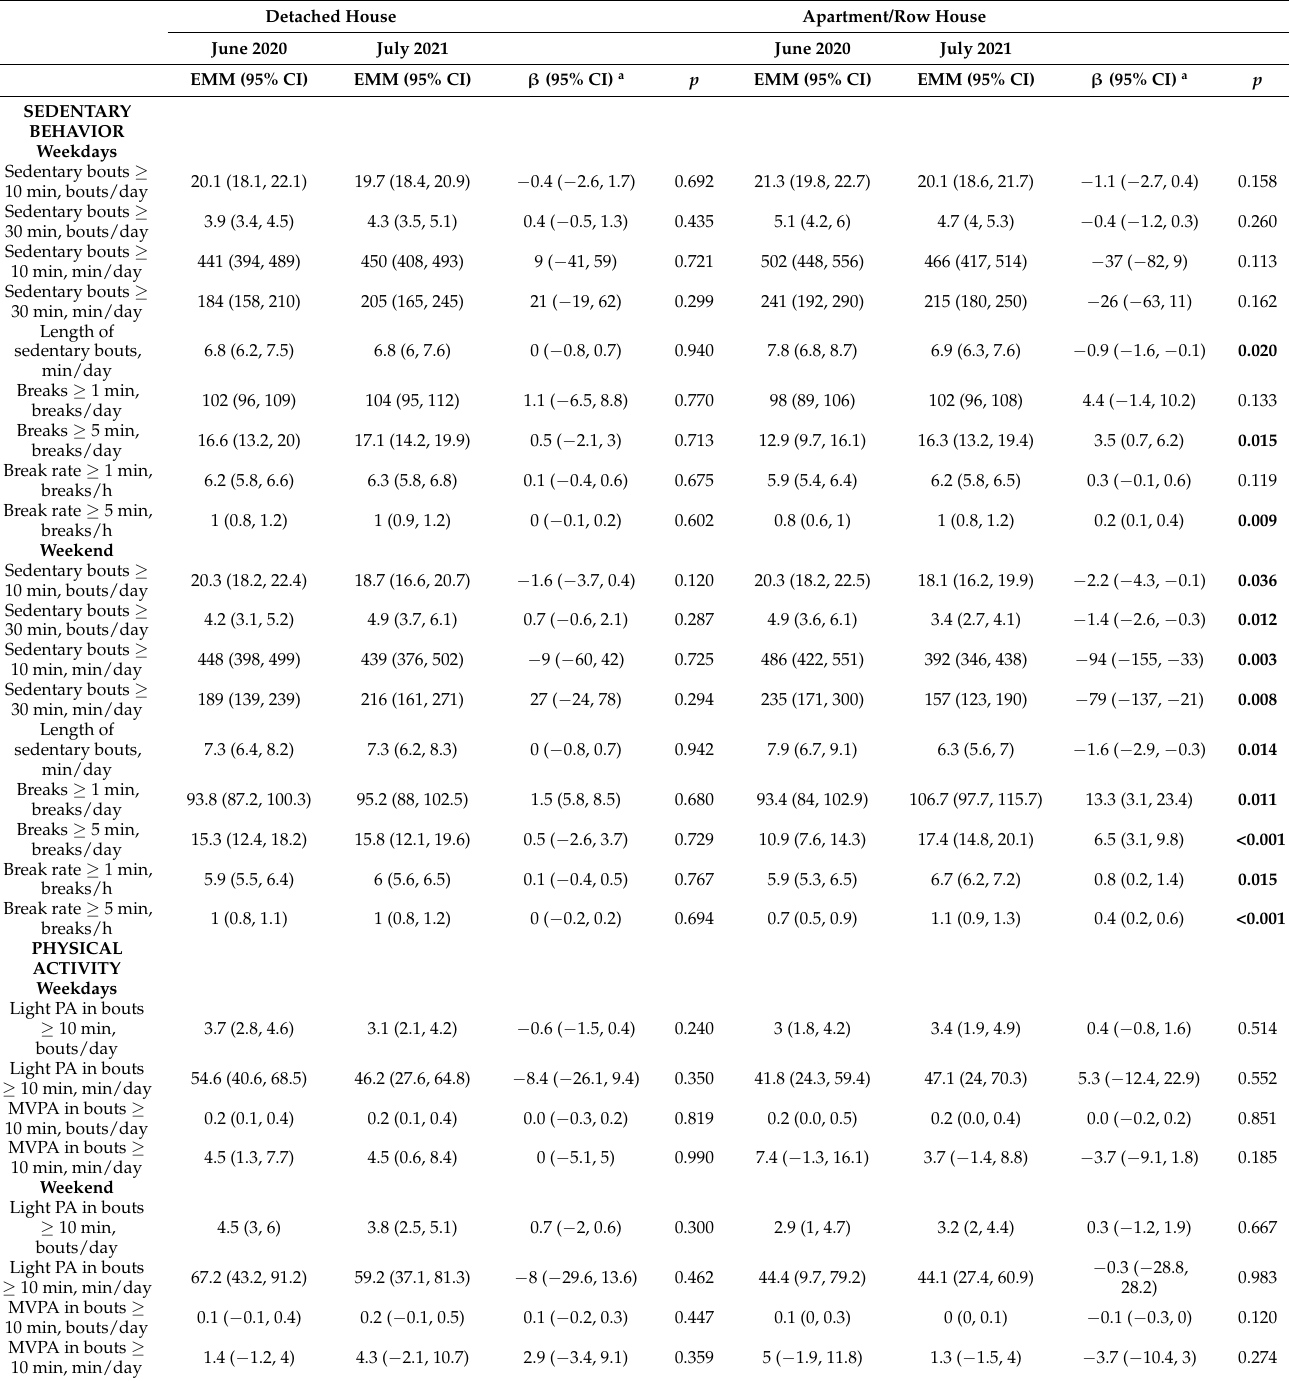
Table 3. Patterns of objectively measured physical activity and sedentary behavior before and after COVID-19 vaccination in older adults with hypertension according to the housing type. Detached